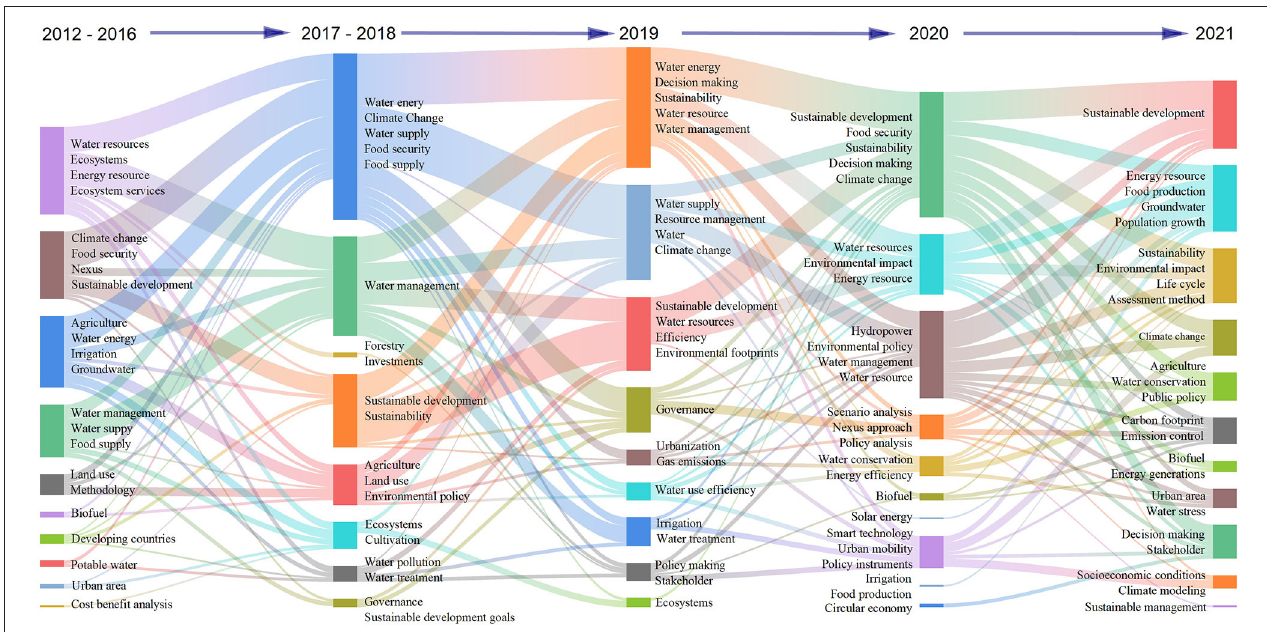
FIGURE 3 | Sankey diagram of the thematic evolution on the WEF nexus research